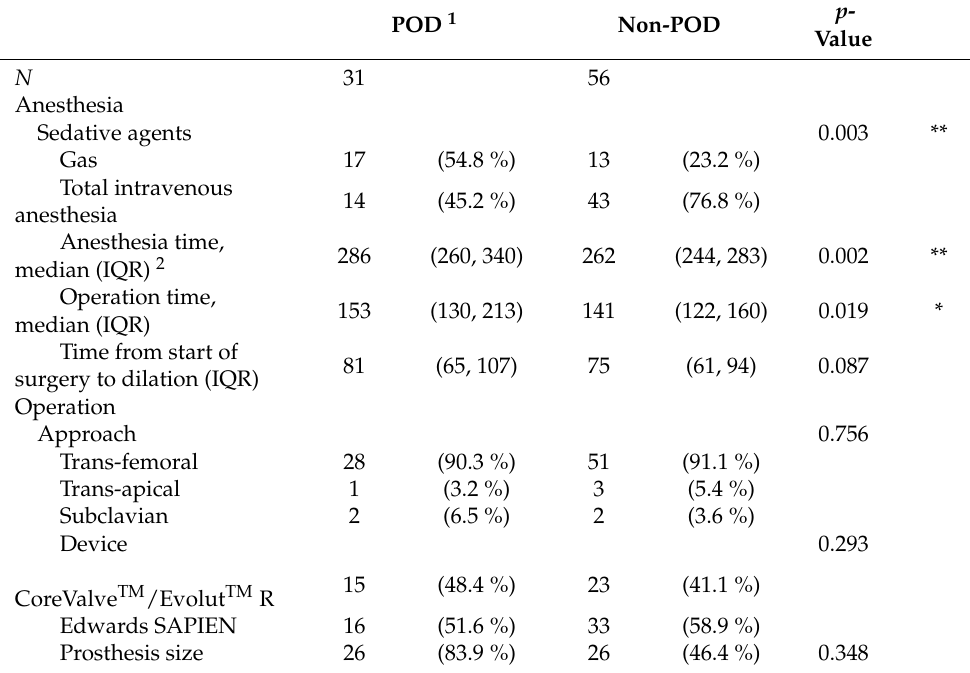
Table 3. Intraoperative factors of